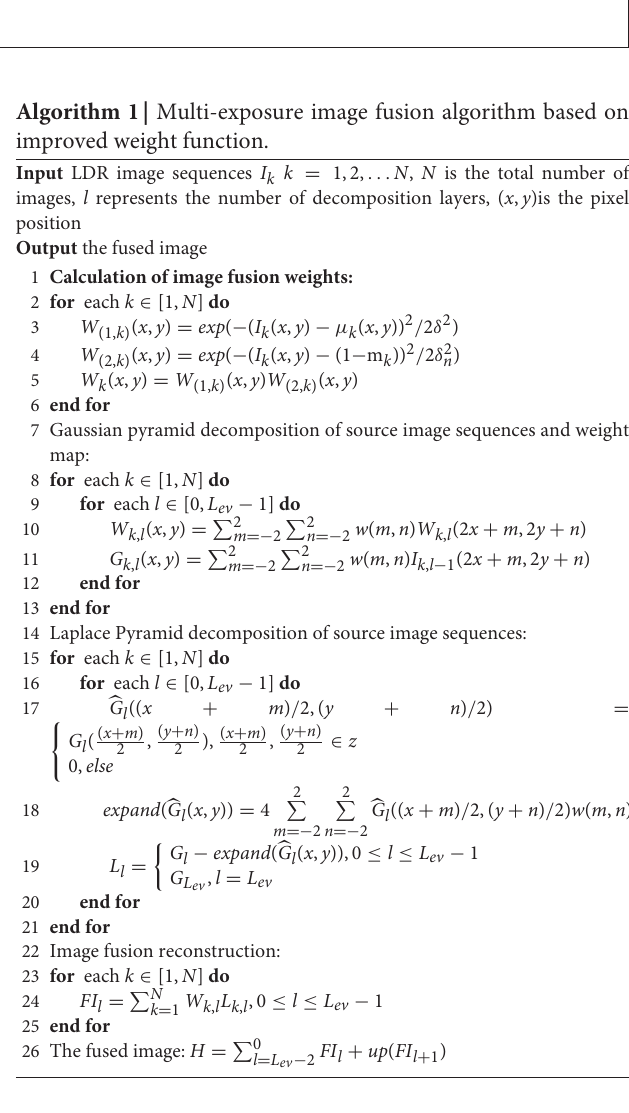
Figure 4 . The fusion results of GD, Fmmr and PMEF are